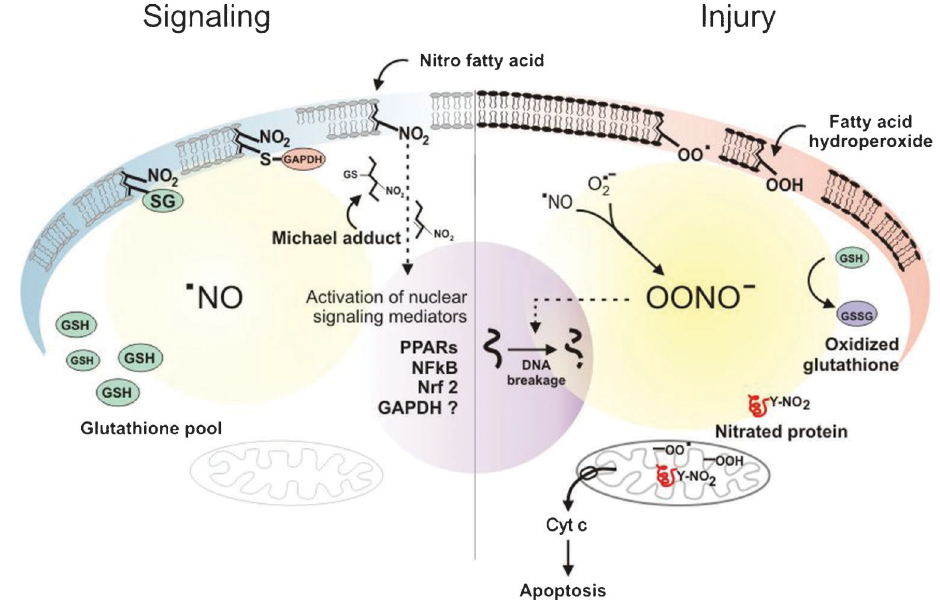
Figure 2. Nitroalkene-activation of anti-inflammatory signaling pathways. On the left side of the scheme, the signaling role of nitroalkenes and nitroalkene thiol adducts on transcription factors is indicated in a cell with normal levels of GSH. On the right side, cytotoxic events predominate as a result of an increase in NOx, leading to pro-oxidant pathways that include GSH depletion, protein tyrosine nitration and lipid oxidation, triggering apoptotic cascades. Adapted from Ref. 47, with